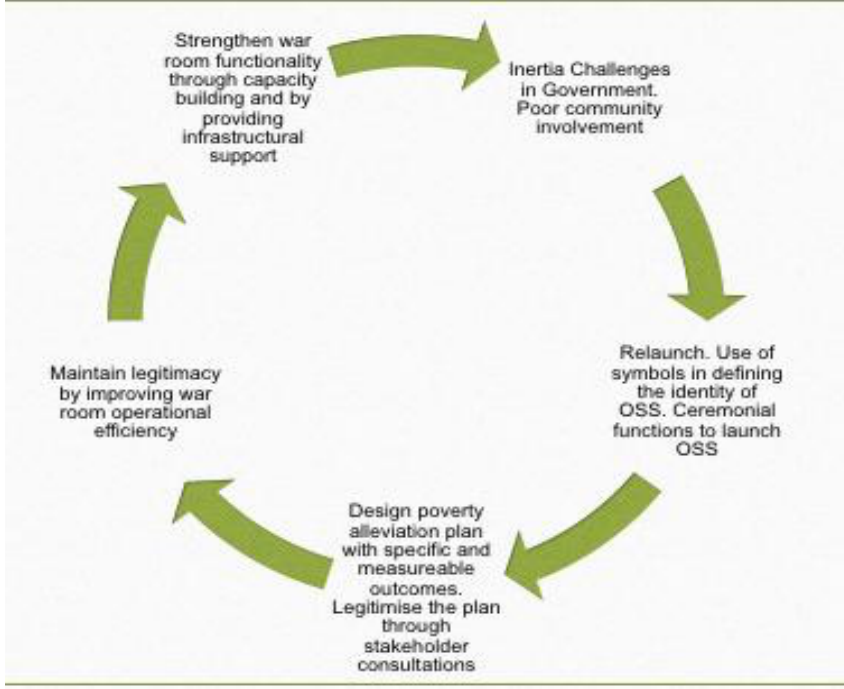
Fig. 2. Five stages of the operation Sukuma Sakhe lifecycle